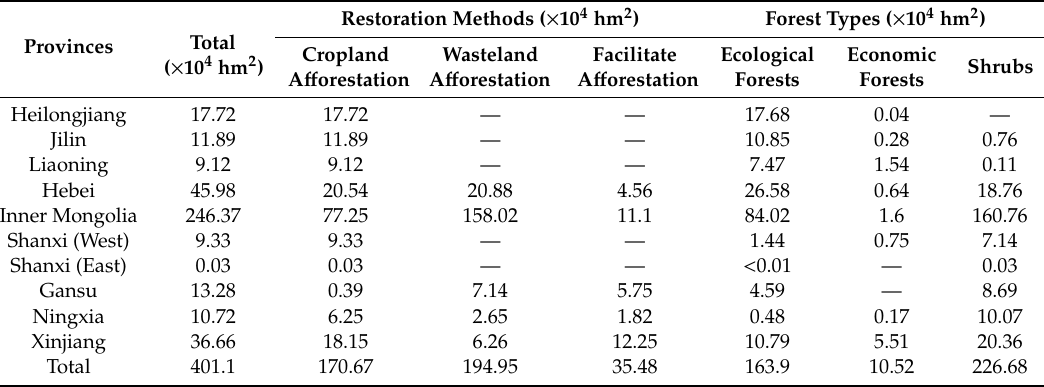
Figure 1. The ecological function zones (State Forestry Administration 2016) and monitoring sites of Grain for Green project in northern China. Table 1. Grain for Green project areas by restoration methods and forest types in different provinces, Northern China.